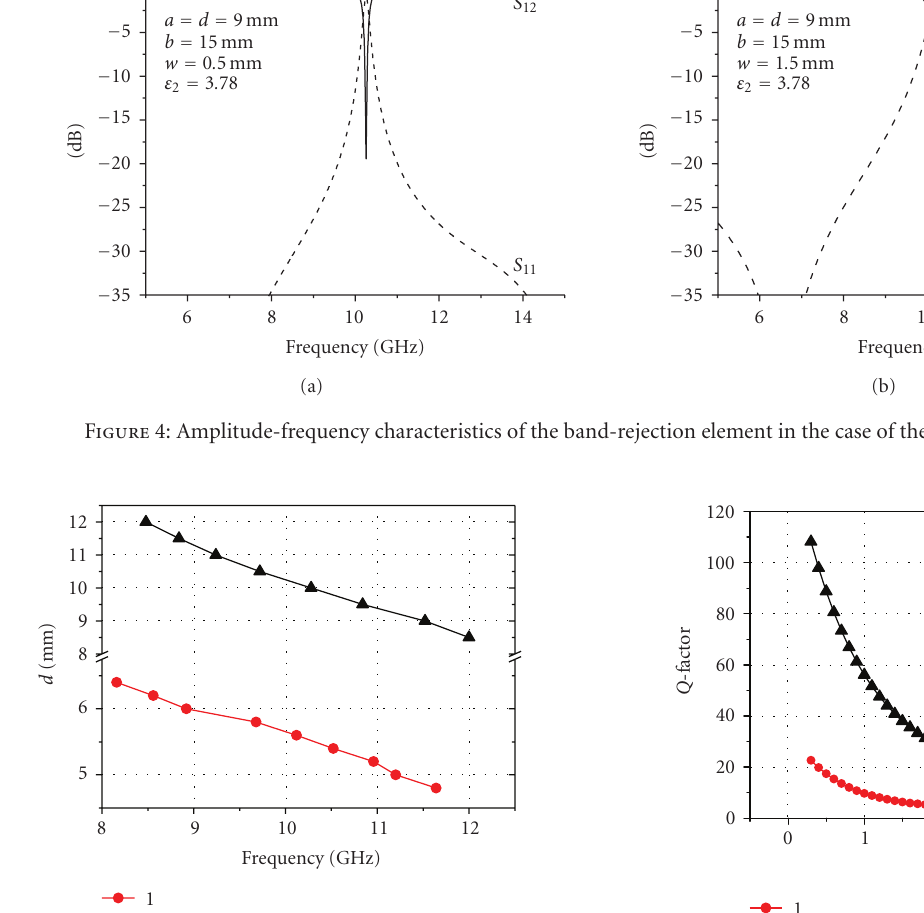
analyzer PNA-L N5230A in the frequency band 8–14